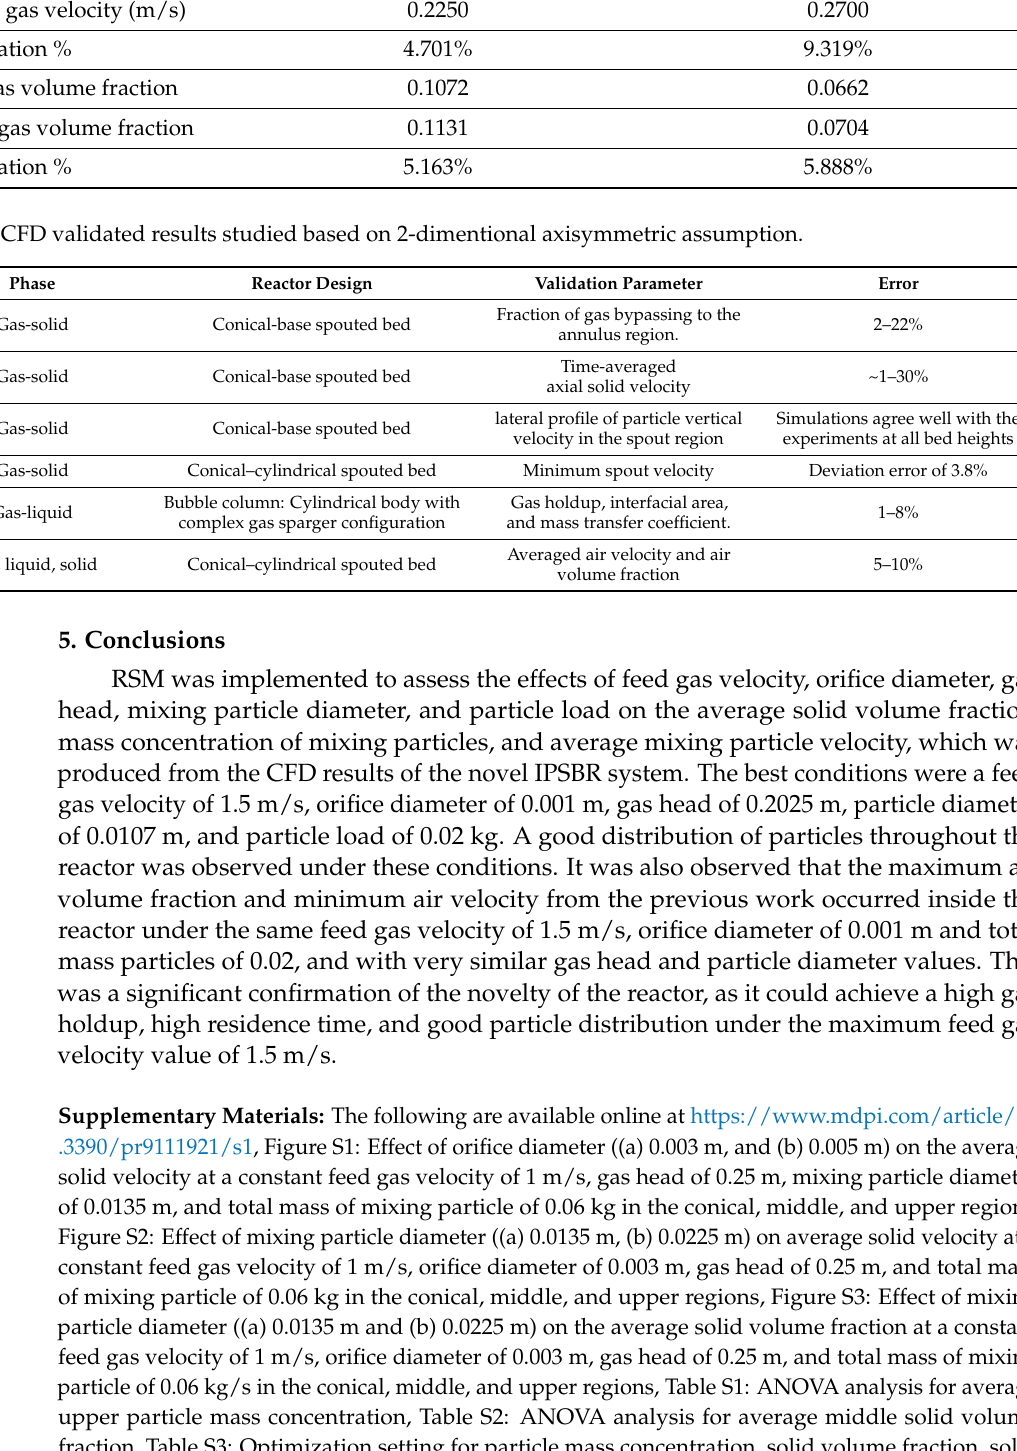
fraction, Table S3: Optimization setting for particle mass concentration, solid volume fraction, solid velocity, air velocity, and air volume fraction, Table S4: Optimum conditions and fitted